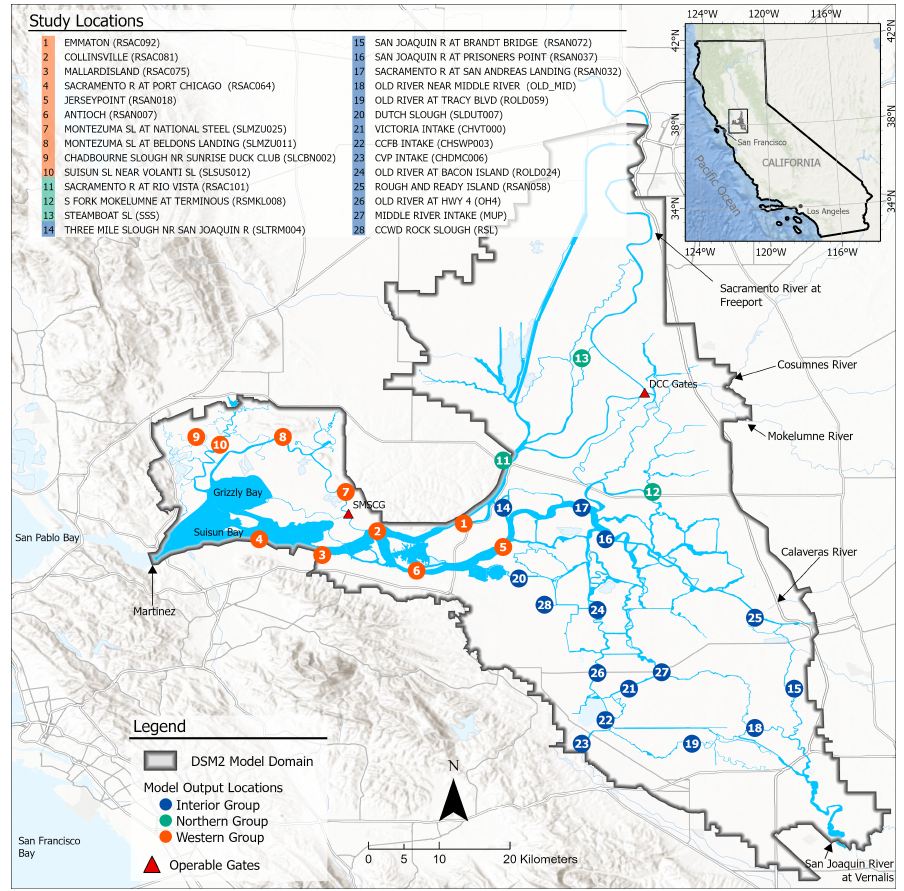
Figure 1. Schematic showing the Sacramento–San Joaquin Delta (Delta), the 28 study locations in three groups, and the model domain of the DSM2 model. The insert map illustrates the location of the Delta in the State of California, United